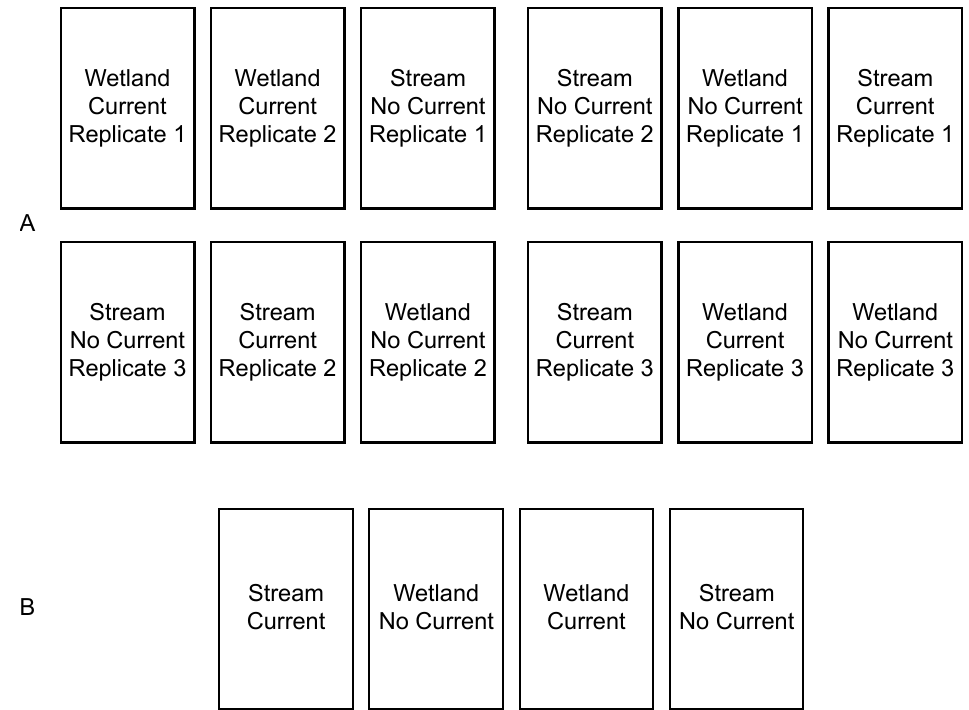
Figure 1. Schematic of experimental treatment allocation within: ( A ) the initial larval facility with 3 replicates for each treatment, and ( B ) the outdoor facility, with a single tank per treatment.